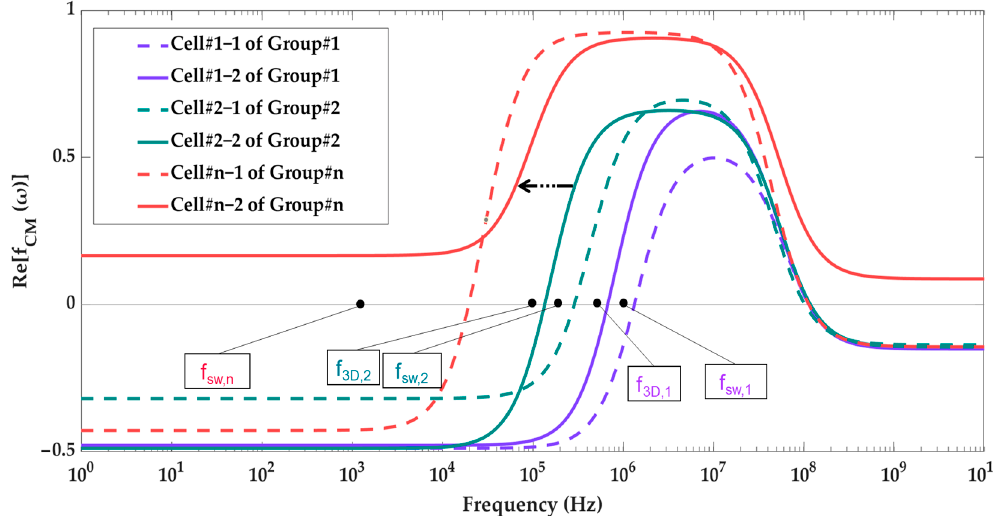
Figure 2. The real part of Clausius − Mosso tt i (CM) factor for cells of group 1 to n. Group number two has the cells whose crossover frequencies are right after Group one cells (Figure 2). This procedure continues until the last two cell types.